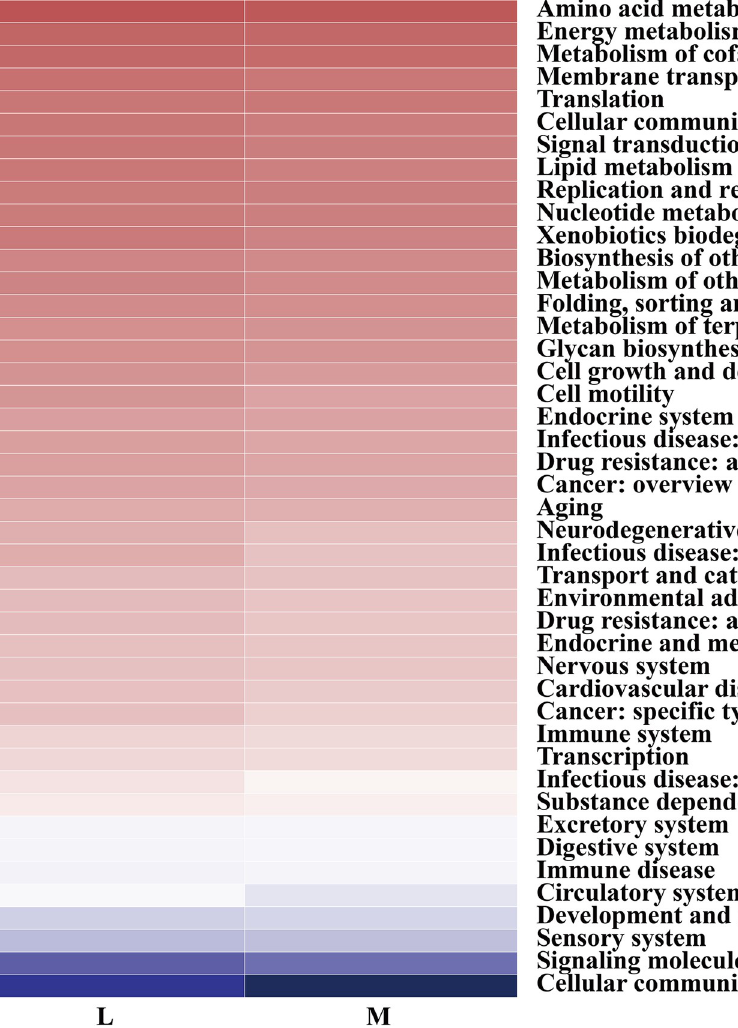
Fig 9. Variations in predicted functional profiles between moss- (M) and non-moss growth (L) areas in litchi orchard (hierarchy level